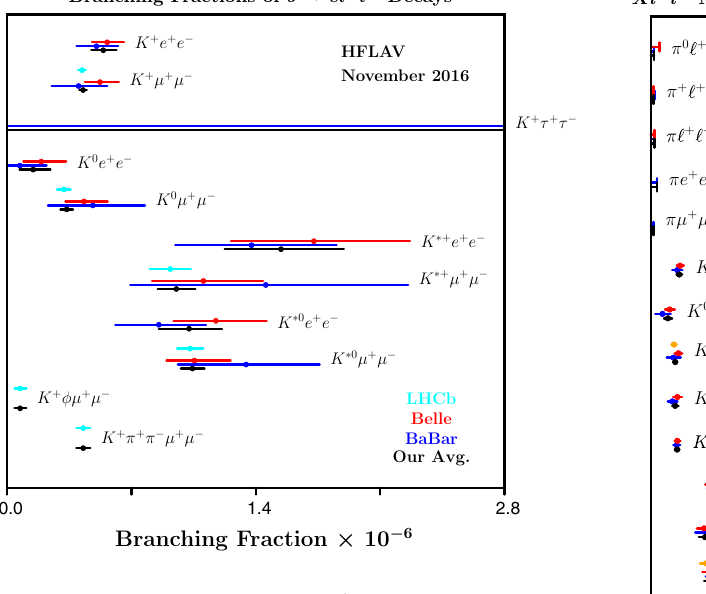
Fig. 182 Branching fractions of b → s (cid:12) + (cid:12) − decays Branching Fractions of b → l + l − ( l + l − ) ,l + l − γ,dl + l − Decays